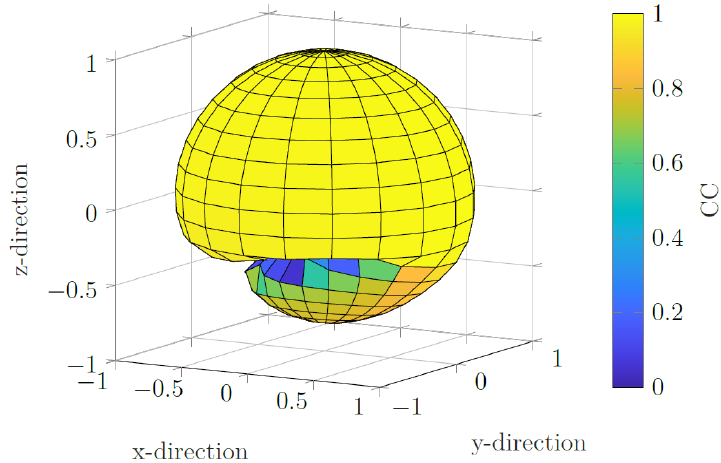
Figure 8. Correlation coefficient for different initial sensitive axis directions. The true sensitive axis lies in the x direction. For the upper half space ( z ≥ 0), the correlation coefficients form a sphere, indicating that the algorithm converges to the true MNP distribution. For the lower half plane, there are regions where the right MNP distribution is not found via the